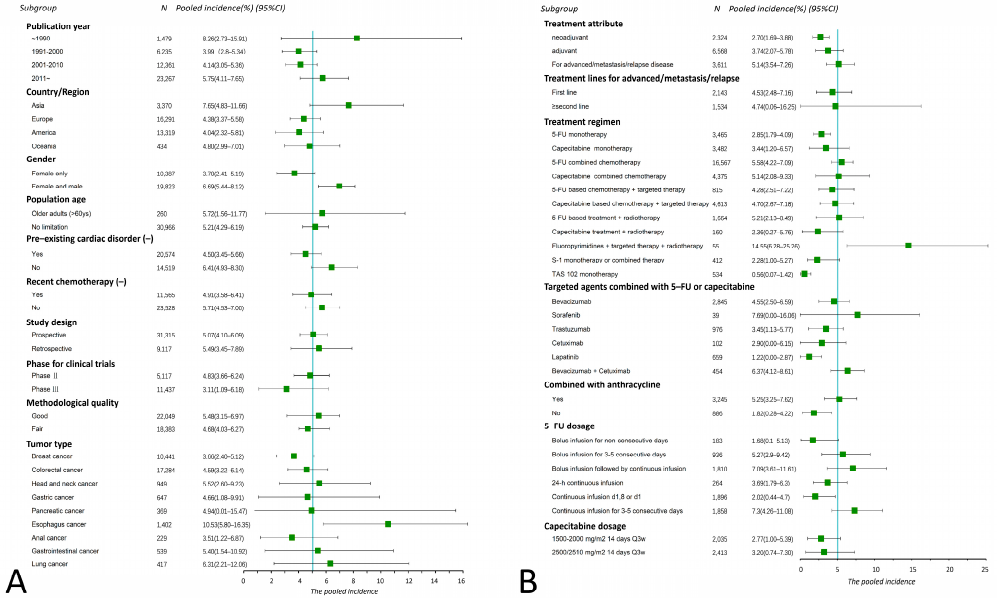
Figure 4. The results of subgroup analysis outcomes of all-grade FAC by basic characteristics ( A ) and treatment details ( B ) of included studies. Each bar and square represent the pooled value of incidence and 95% con fi dence interval for one subgroup. Vertical line indicates the pooled incidence of all-grade FAC (5.04%); “ N ” at the top of this fi gure represents the number of patients included in the evaluation for each subgroup.